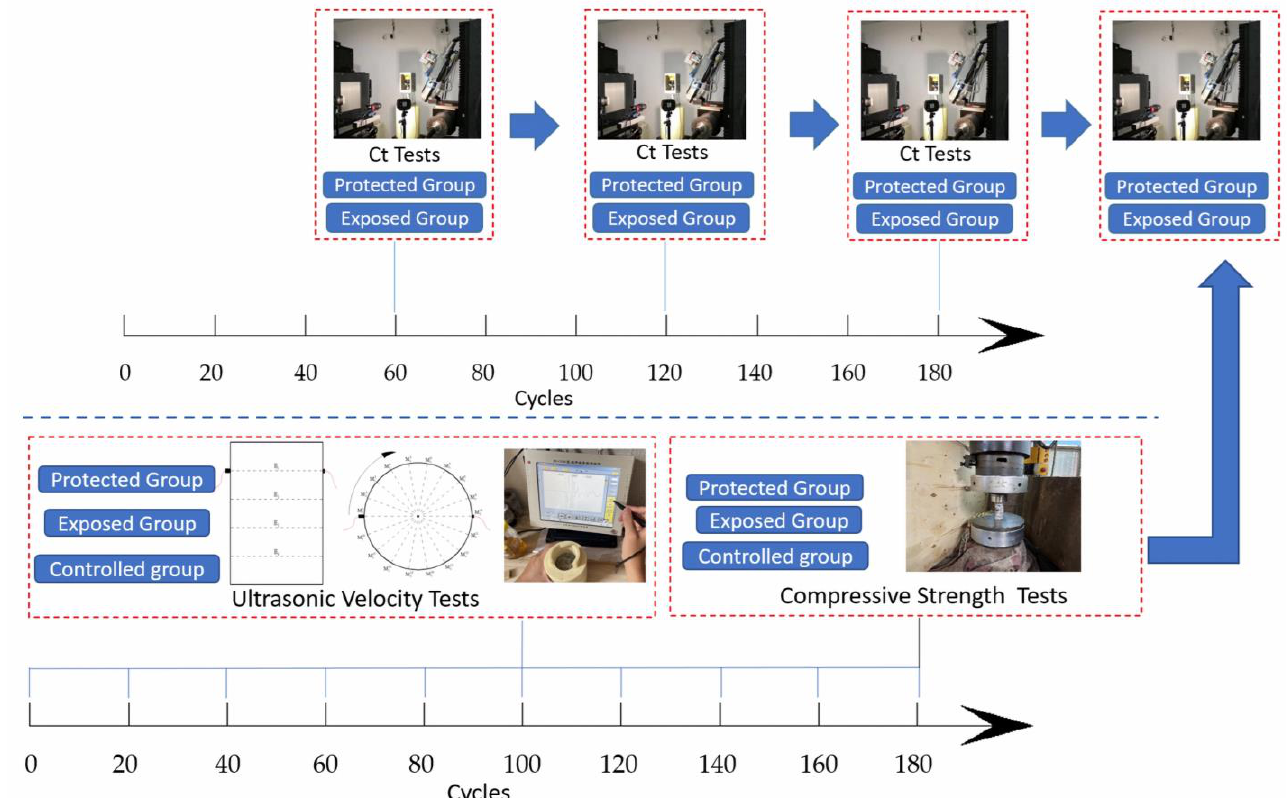
Figure 2. Overall test protocol of the